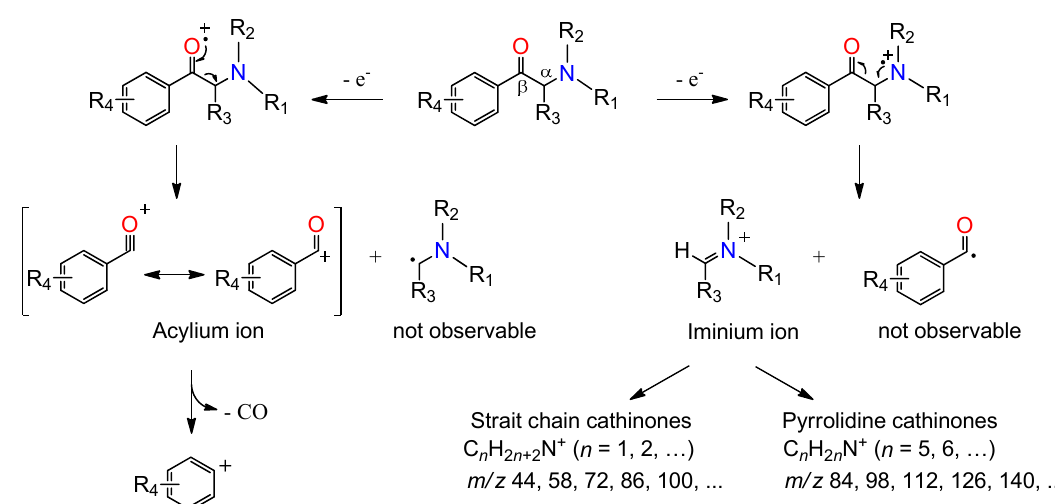
As reported by Zuba [35], the α -cleavage process is a key feature of the mass spectral fragmentation of SCat. This process results in the formation of the iminium ion by fragmen- tation of the C–C bond between the α and β carbon atoms under EI conditions (Figure 4). In the case of cathinones with a straight-chained aliphatic side ring, the structural formula of the base iminium ion is represented by C n H 2n+2 N + ( n = 1, 2, . . . ), resulting in a base peak of mass-to-charge ratio ( m / z ) 44, 58, 72, 86, 100 and so on, depending on the number of carbon atoms contained in the iminium ion [35,36]. N -Ethylcathinone, buphedrone, pentedrone, methedrone, methylone and 3-FMC are SCat that produce typical C n H 2n+2 N + iminium ions. For cathinones with a pyrrolidine ring in the side chain, such as MPHP and α -PHP, fragmentation leads to the formation of characteristic ions represented by the structural formula C n H 2n N + ( n = 5, 6, . . . ), which corresponds to R 3 CH=N + (C 4 H 8 ) species [35]. The consequent fragmentation of the pyrrolidine ring leads to the formation of characteristic ions m / z 70, 55, 42 and 41 [35,37].